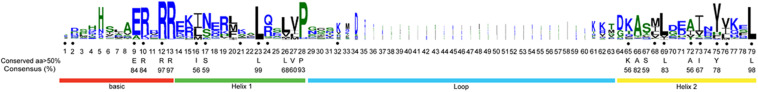
bHLH domain is highly conserved across all MabHLH proteins. The overall height of each stack represents the conservation of the sequence at that position. The black dot indicates the position of the 19 conserved amino acids previously identified by Atchley and Fitch (1997), and capital letters indicate over 50% conservation of amino acids among the 259 MabHLH domains.